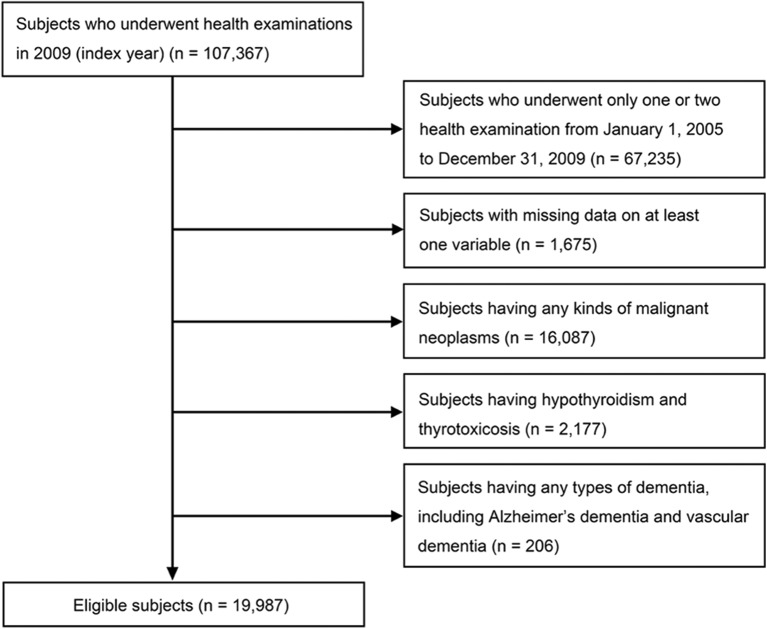
Flowchart of the study population.